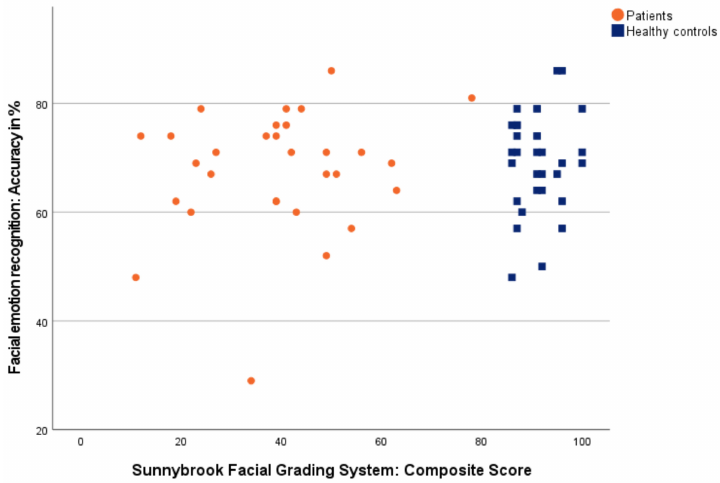
Figure 5. Correlation between accuracy of facial emotion recognition and grading of facial palsy. Patients are shown as orange dots, and healthy controls as blue squares.